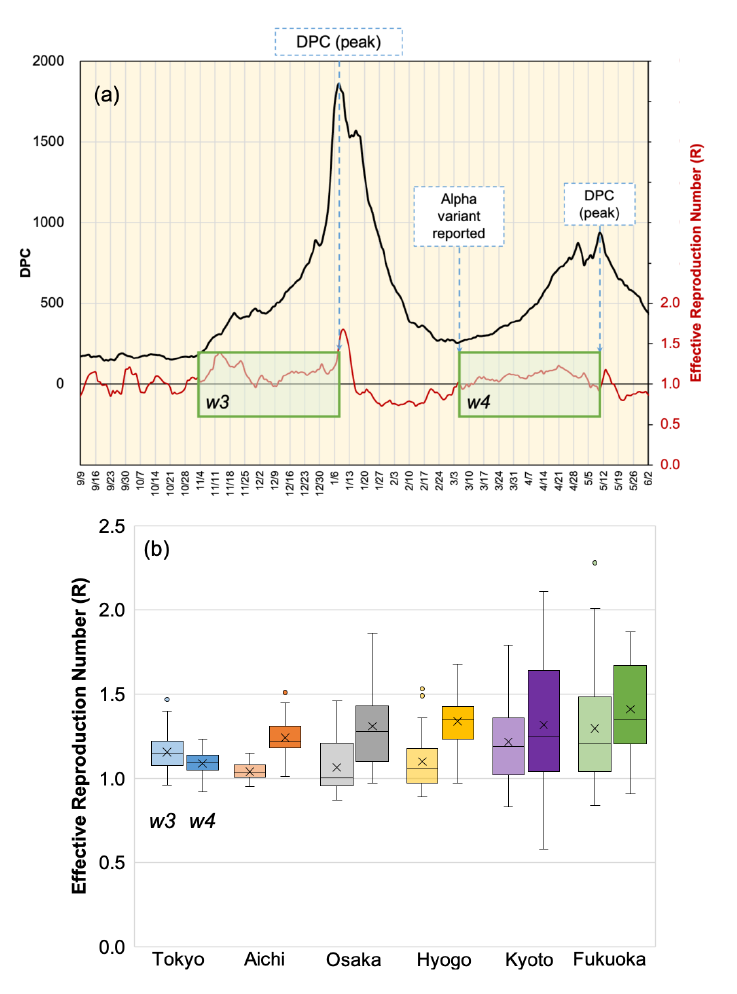
Figure 8. ( a ) Definition of two time slots w 3 and w 4 preceding the third and fourth pandemic waves, respectively. Time slots ended with the day of the DPC local maximum value and the width was defined by the first day where the Alpha variant was reported. ( b ) Box plot of R values computed in w 3 ( left ) and w 4 ( right ) in different